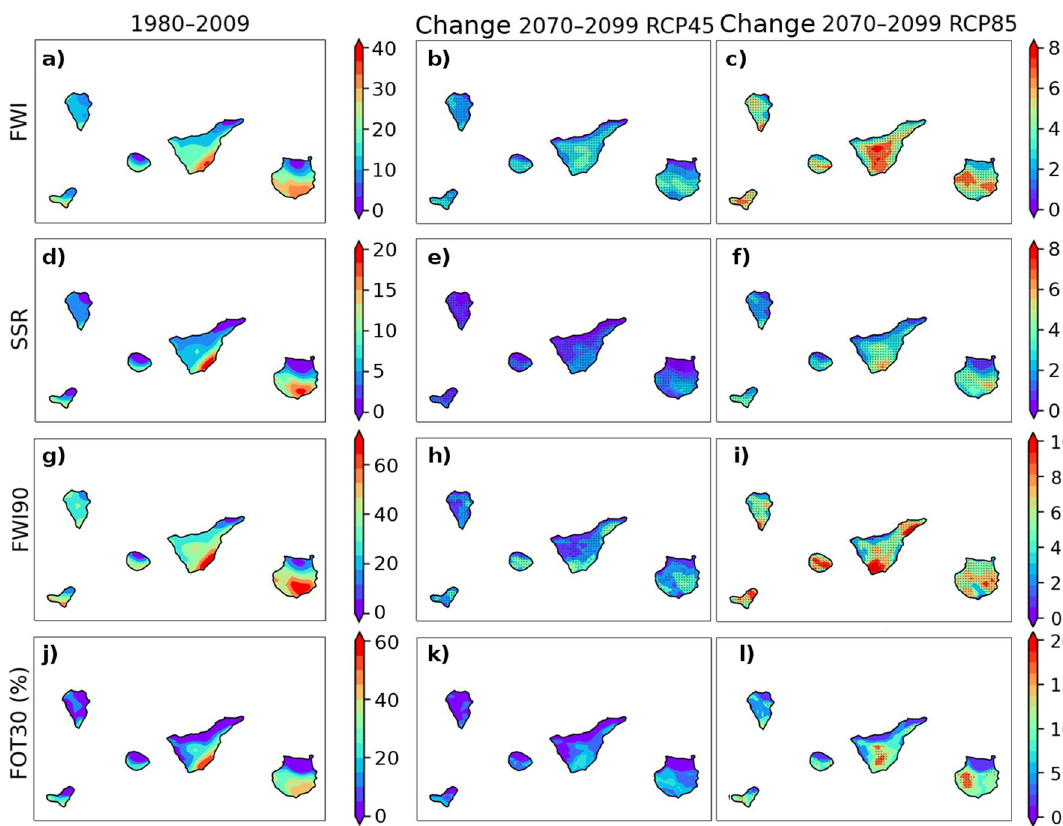
Figure 3. Evolution of the spatial distribution of the median values across three models of the annual means of FWI ( a , b , c ), SSR (Seasonal Severity Rating) ( d , e , f ), FWI90 (the 90th percentile of FWI) ( g , h , i ), and FOT30 (percentage of days with an FWI greater than 30) ( j , k , l ) indices, between recent past (1980–2009) ( a , d , g , j ) and future (2070–2099) under the two scenarios RCP4.5 ( b , e , h , k ) and RCP8.5 ( c , f , i , l ). Robust changes are marked with